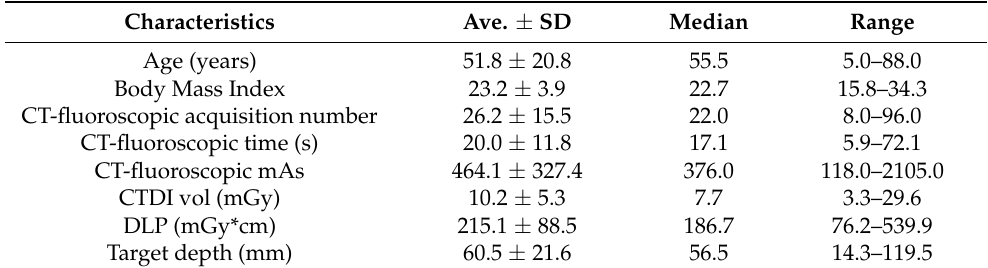
Summary of our 18-month study on patients undergoing CTF-guided biopsies (95